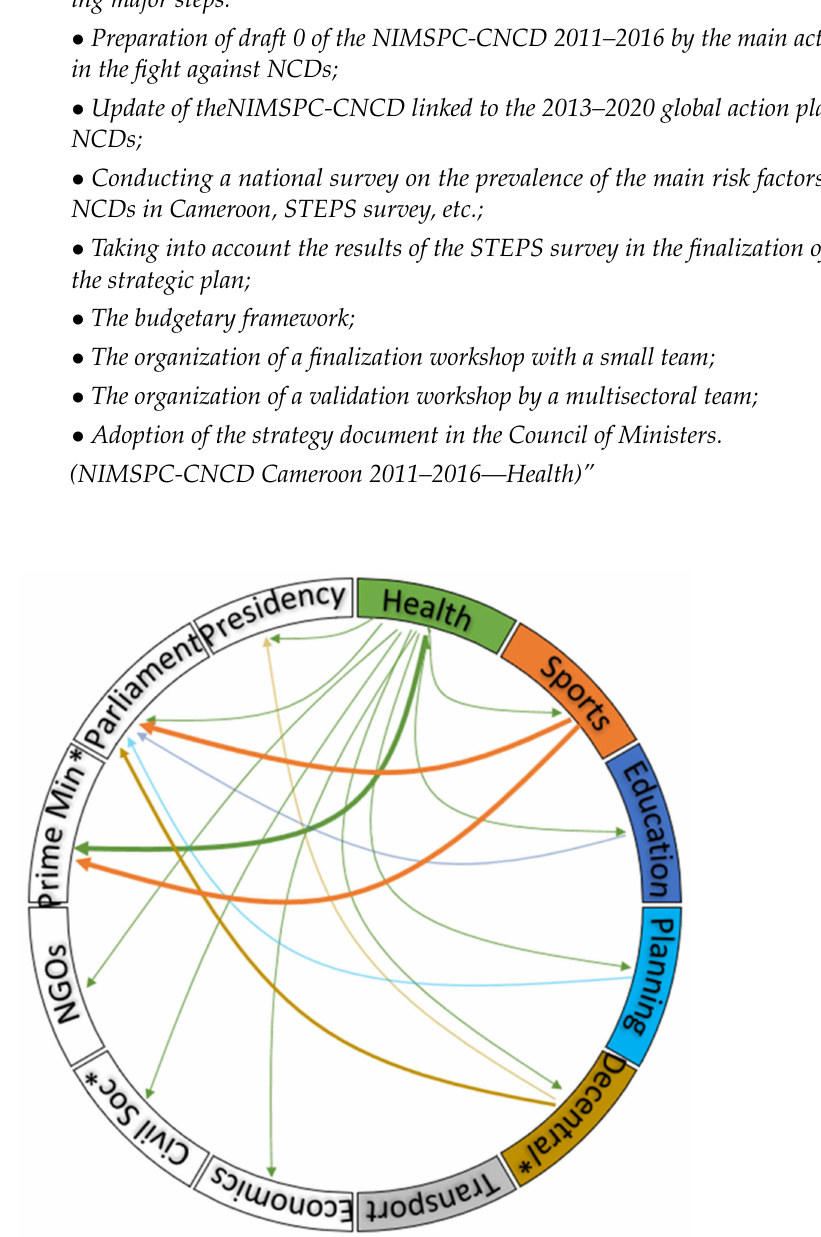
Figure 2. Main actors involved in physical activity related policies in Cameroon. Boxes represent the sectors that owned the policies; the arrows point to the sector that collaborated in a policy; and the thickness of the line represents the number of policy documents in which a sector